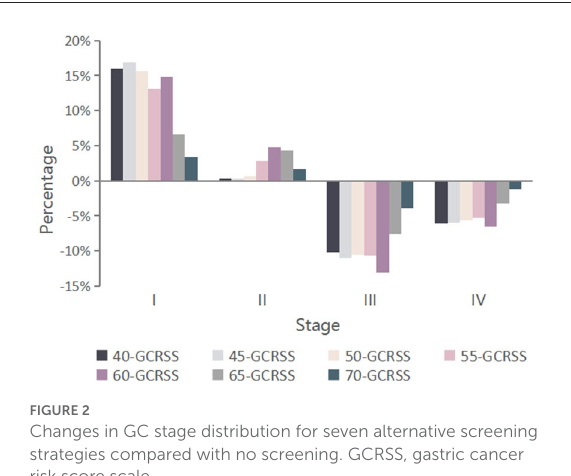
FIGURE2 Changes in GC stage distribution for seven alternative screening strategies compared with no screening. GCRSS, gastric cancer risk score